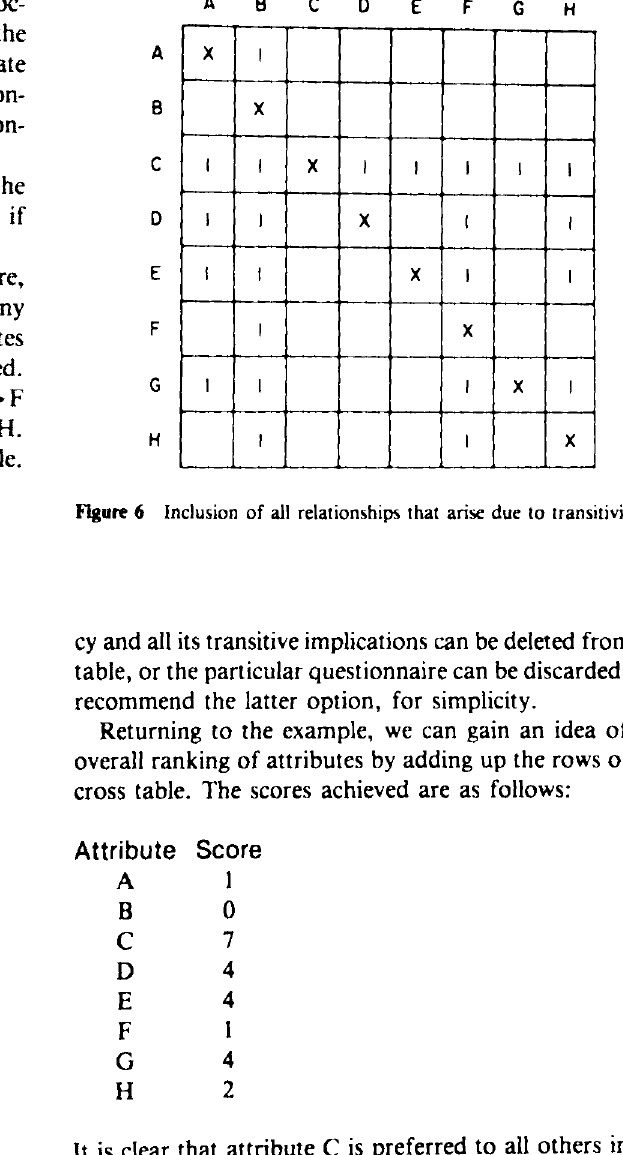
Figure 5 Addition of relationships C>F and